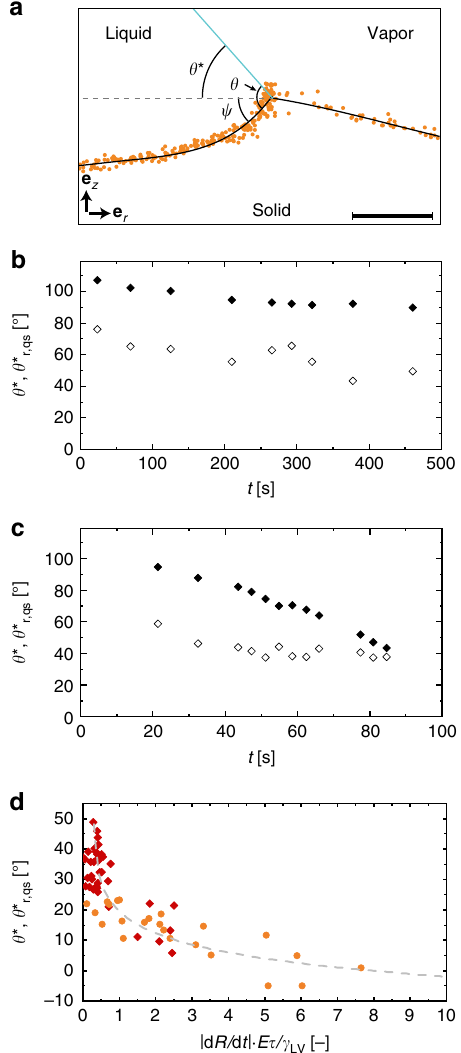
Fig. 5 Mechanism of dynamically triggered wetting transition. a Schematic showing a contact line pinned on a sharp quasi-static apex and the de fi nitions of the apparent contact angle, θ * , the angle between the liquid – solid interface and the horizontal, ψ , and the angle between the liquid – vapor and liquid – solid interface, θ . At contact line depinning, the condition θ = θ r has to be satis fi ed. The black line is a piecewise polynomial fi t of fi fth order. Theoretical receding contact angle, θ (cid:1) (empty diamonds), r ; qs and θ * ( fi lled diamonds) vs. t for a contact line pinned on a quasi-static apex for b slow evaporation ( rH = 90%, droplet from Fig. 3a) and c rapid evaporation ( rH = 15%, droplet from Fig. 3d) of a droplet on a compliant substrate. d Difference between the apparent contact angle, θ * , and the theoretical receding contact angle if the wetting ridge acts as a quasi-static defect, θ (cid:1) , as a function of | dR / dt | E τ / γ LV . We tested two material r ; qs compositions of Silicone CY 52 – 276, ratio 5:6 (orange, N = 4, with 24 time steps) and ratio 9:10 (red, N = 5, with 38 time steps), with rH of 15 ± 1% and 90 ± 1% and at room temperature ( T = 24 °C). The gray dashed line is a logarithmic fi t with three parameters. Scale bar: a 5 µ m (with an aspect ratio of 1:1). Source data are provided as a Source Data fi le for ( b – d